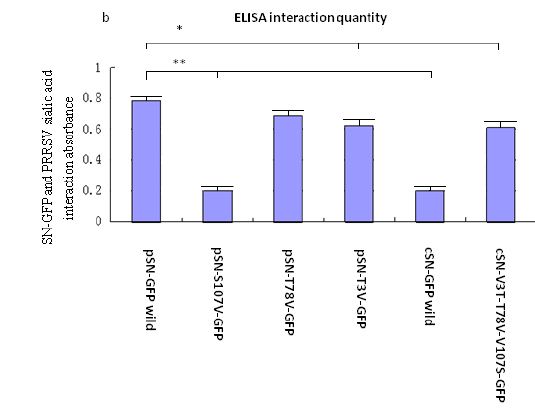
Figure 6. Binding activity of PRRSV to six different types of SN-GFP chimeric proteins were tested using ELISA. ( A ) Standard curve for the binding activity of different concentrations of wild-type SN-GFP with PRRSV; and ( B ) Binding activity of PRRSV to the different SN-GFP chimeric proteins. * significance; ** very significance .